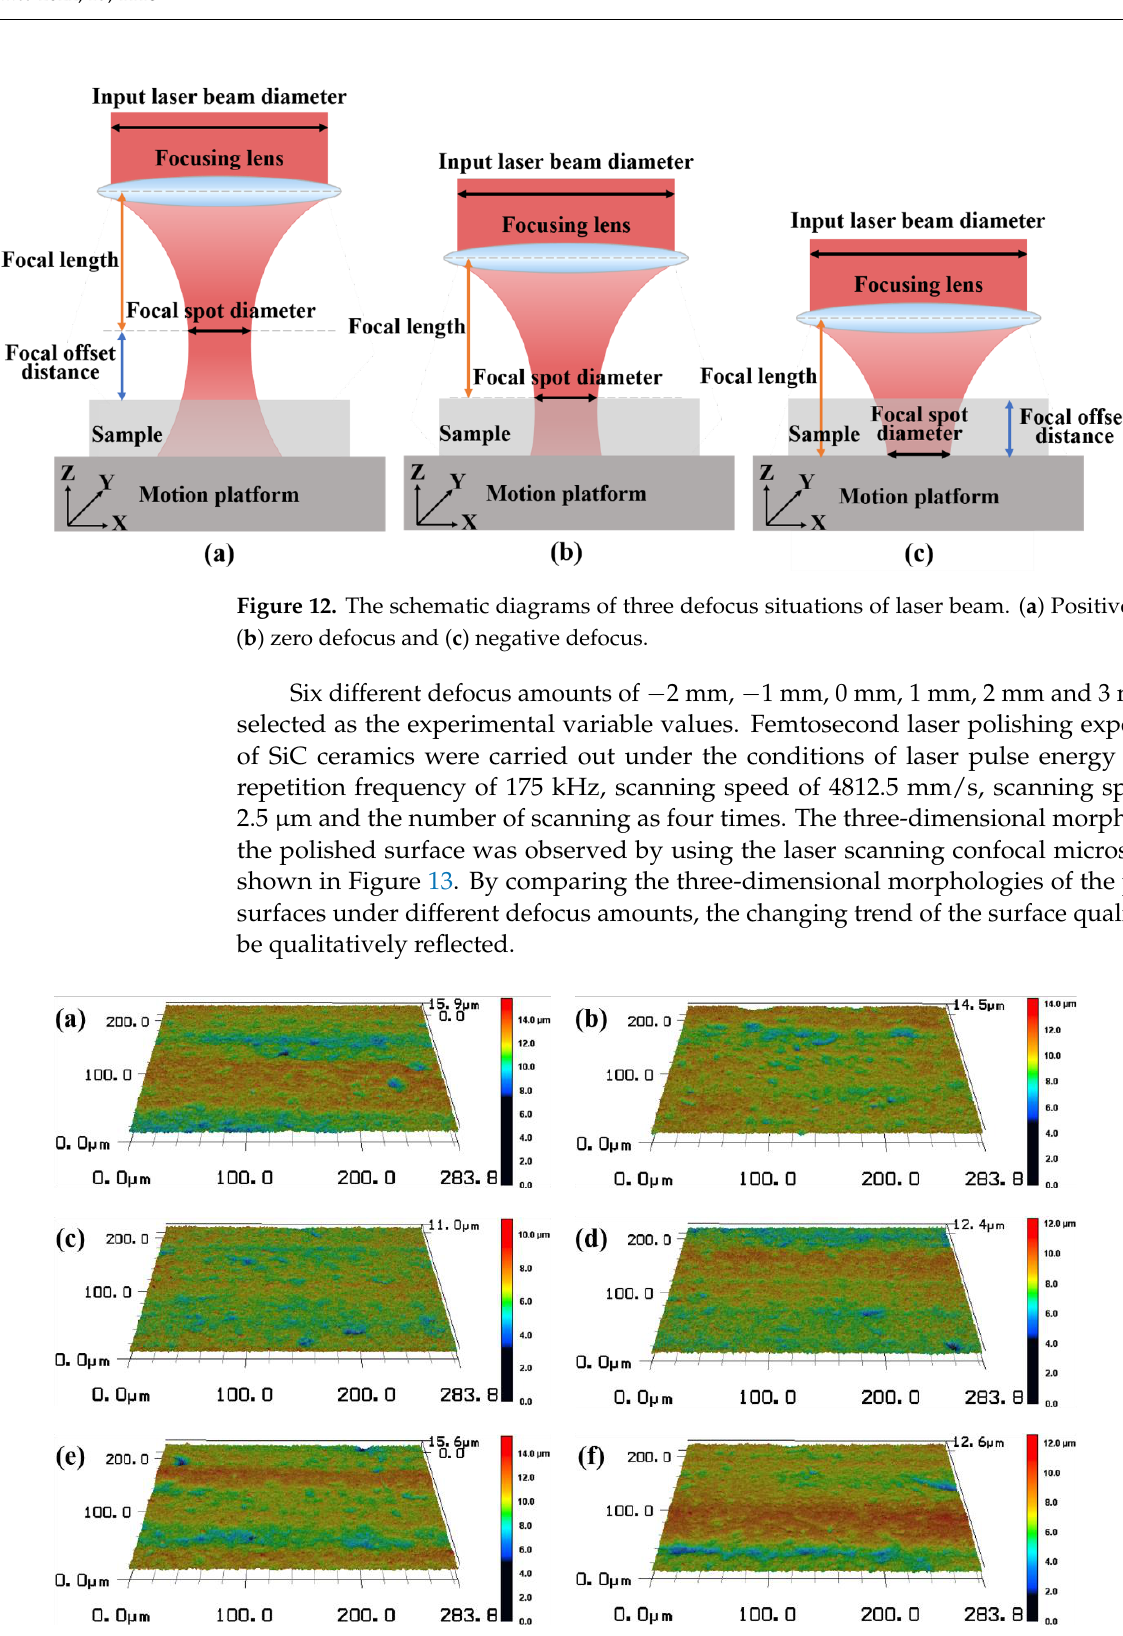
Figure 13. The three-dimensional topographies of the surface after polishing with different defo- cus amounts (magnification 1000). ( a ) −2 mm, ( b ) −1 mm, ( c ) 0 mm, ( d ) 1 mm, ( e ) 2 mm, ( f ) 3 mm. amounts (magnification 1000). ( a ) − 2 mm, ( b ) − 1 mm, ( c ) 0 mm, ( d ) 1 mm, ( e ) 2 mm, ( f ) 3